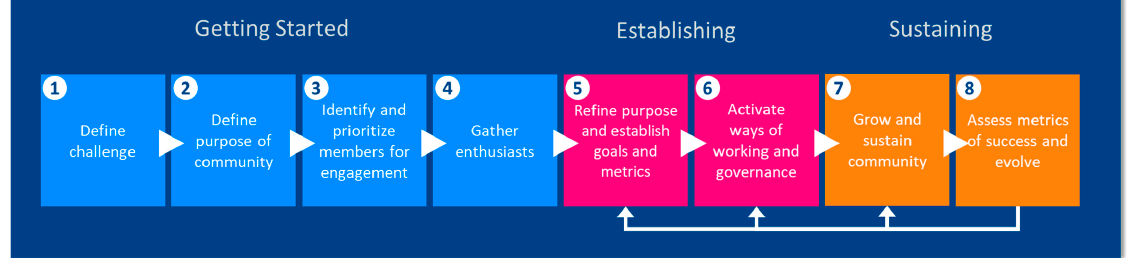
Figure 1. Community development framework. Sources that influenced and guided this framework include